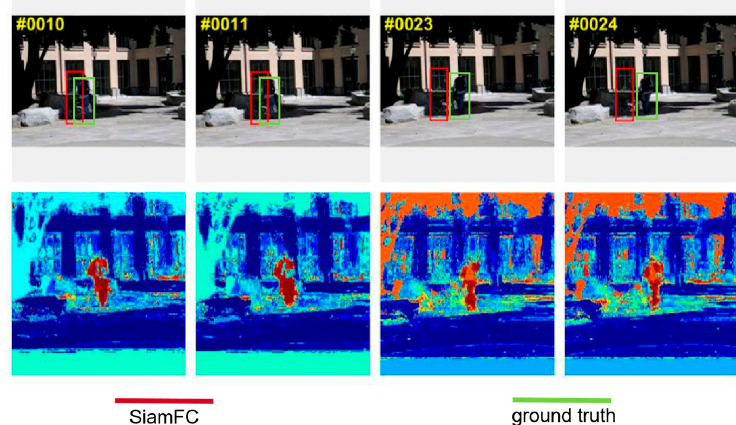
Figure 2. ( top ) Four frames (#0010, #0011, #0023, and #24) of SiamFC’s tracking failure in Human8 sequence; ( bottom ) histogram maps of each frame corresponding to first row (#0010, #0011, #0023, and #24), the red region in the map represents high score.